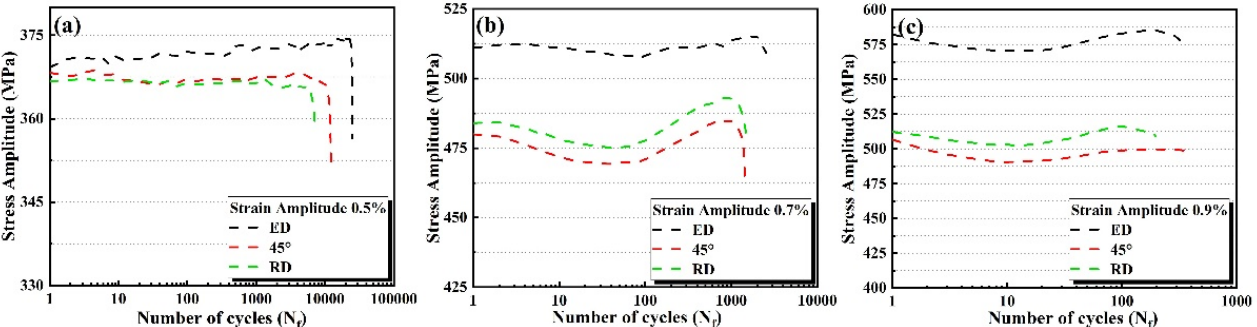
Figure 10. The stress amplitude vs. number of cycles for ( a ) 0.5%, ( b ) 0.7 and ( c ) 0.9% specimens under different strain amplitudes.